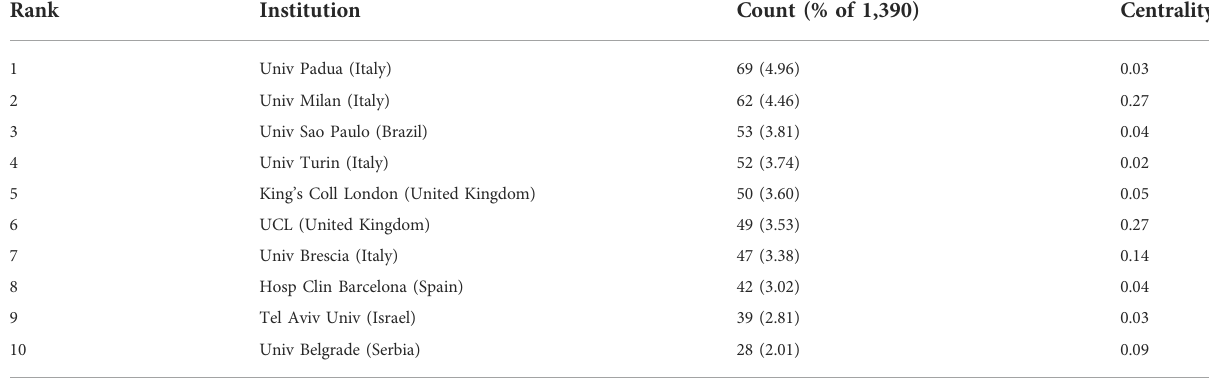
TABLE 2 Top 10 most productive institutions related to APS.